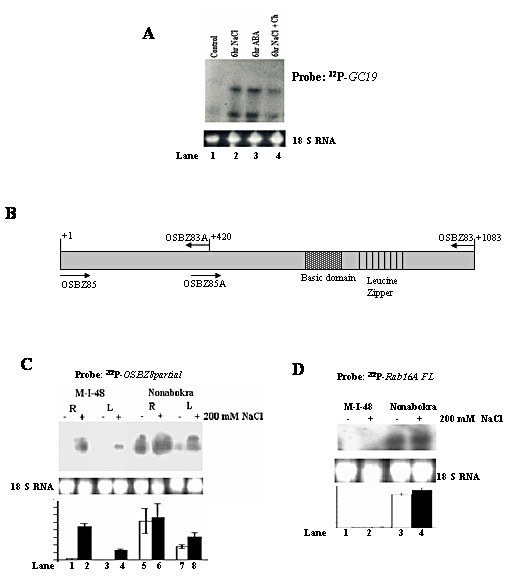
Northern blot analysis of total RNA from different varieties of rice. A. Blot with equal amount of total RNA isolated from roots of Pokkali plants probed with [32P]-GC19 (encoding highly conserved basic domain), showed hybridization with two transcripts of size 2.2 kb and 1.3 kb, both of which appeared after treatment of plants either with 200 mM NaCl (lane 2) or with 100 μM ABA (lane 3) or with NaCl and cycloheximide (Ch, lane 4), together. B. Physical map of the entire ORF for OSBZ8 showing the positions of the primers used in the amplification of full length OSBZ8 or OSBZ8p. C. Northern blot with total RNA from roots (R) and lamina (L) of M-I-48 and Nonabokra probed with the unique region of OSBZ8. Transcript abundance is shown both in control and treatment with 200 mM NaCl (lane 1, 2, 3 and 4 in M-I-48; and lane 5, 6, 7 and 8 in Nonabokra). D. Northern blot with total RNA from lamina of M-I-48 (lane 1 and 2), and Nonabokra (lane 3 and 4), probed with Rab16A full length. Histogram drawn from the values obtained by the densitometric scanning of each lane is shown under each autoradiogram. Mean values ± SD of three independent experiments are shown.